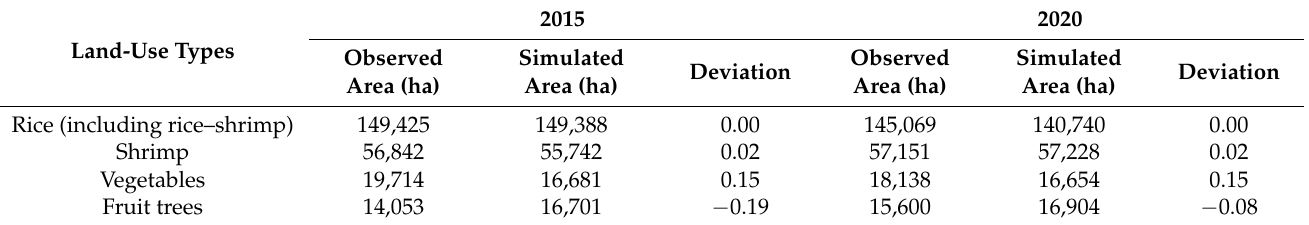
Table 2. Comparison of land use simulated with the observed data in 2015 and 2020.